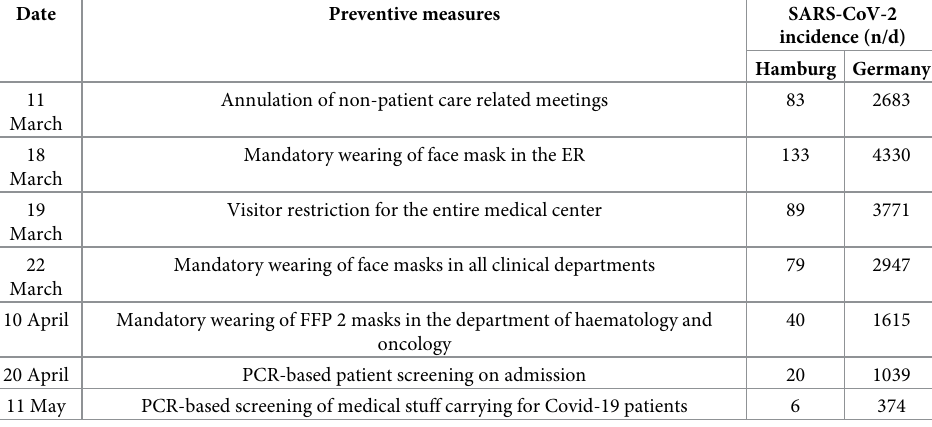
Table 1. Chronological listing of the preventive measures, local and national incidence of SARS-CoV-2. The first patient of this study was enrolled on 2 April